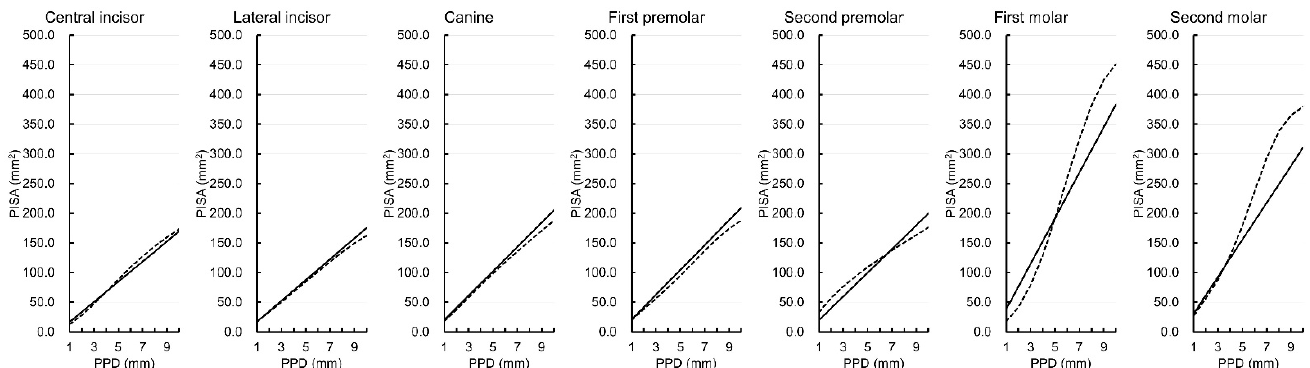
Figure 1. Simulated periodontal epithelial surface area (PISA) for probing pocket depths (PPDs) of 1 to 10 mm with bleeding on probing positivity at all six sites around the tooth in the Japanese version (solid lines) and original version (dotted lines) [1] for each tooth type in the maxilla.